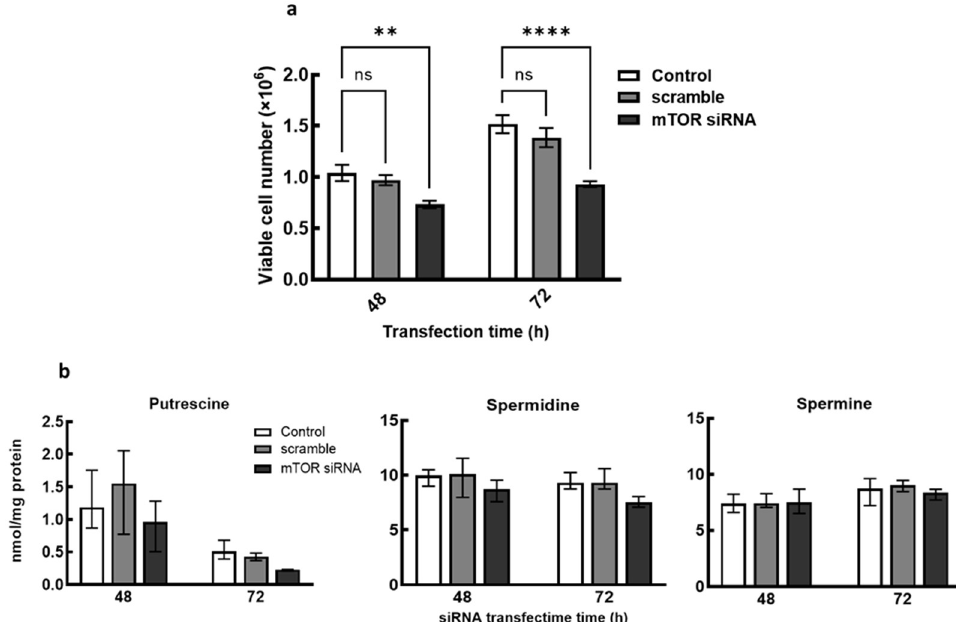
Figure 4. Effect of mTOR siRNA gene knockdown of growth and polyamine content. MCF-7 cells were grown to 50% confluence in 6-well plate and transfected with mTOR siRNA (30 nM final concentration) for 48 h and 72 h, thereafter cells were harvested. ( a ) Cell number was determined after 48 h and 72 h mTOR siRNA transfection by trypan-blue exclusion assay. ( b ) Polyamine content of cells after mTOR siRNA transfection was estimated by LC-MS. Values shown are mean ± S.E.M, for three independent experiments for ( a ) and mean ± range, for two independent experiment for ( b ), with two replicates per treatment and analyzed using ANOVA and Dunnett’s post-test, where ** p < 0.01, **** p < 0.0001. Control represents untreated cells, ns represents no significant